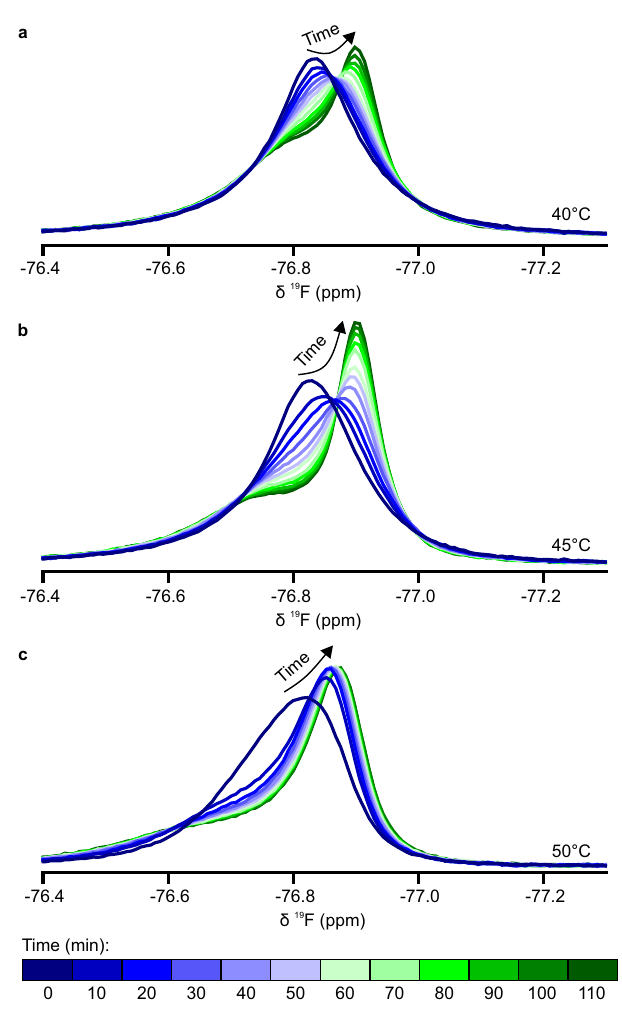
Fig. 3 Examples of bulk-detected 19 F NMR spectra of TFE in BSA undergoing microscopic LLPS at different temperatures following a temperature jump. Spectra at 40 °C ( a ), 45 °C ( b ) and 50 °C ( c ). The representative spectra shown here are sampled at 10 min intervals, from t = 0 to 110